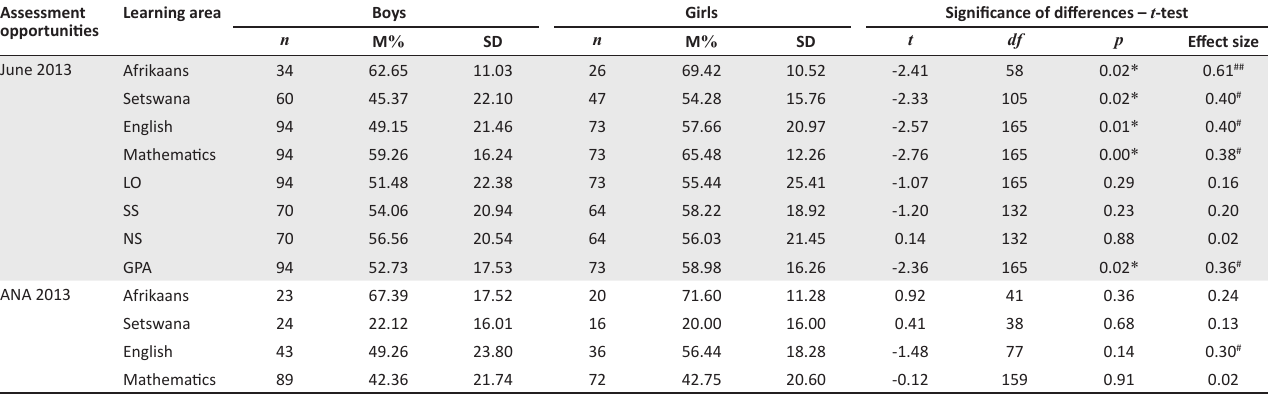
TABLE 4: Gender differences in academic achievement of typical developing learners (˃16th percentile). Assessment Learning opportunities